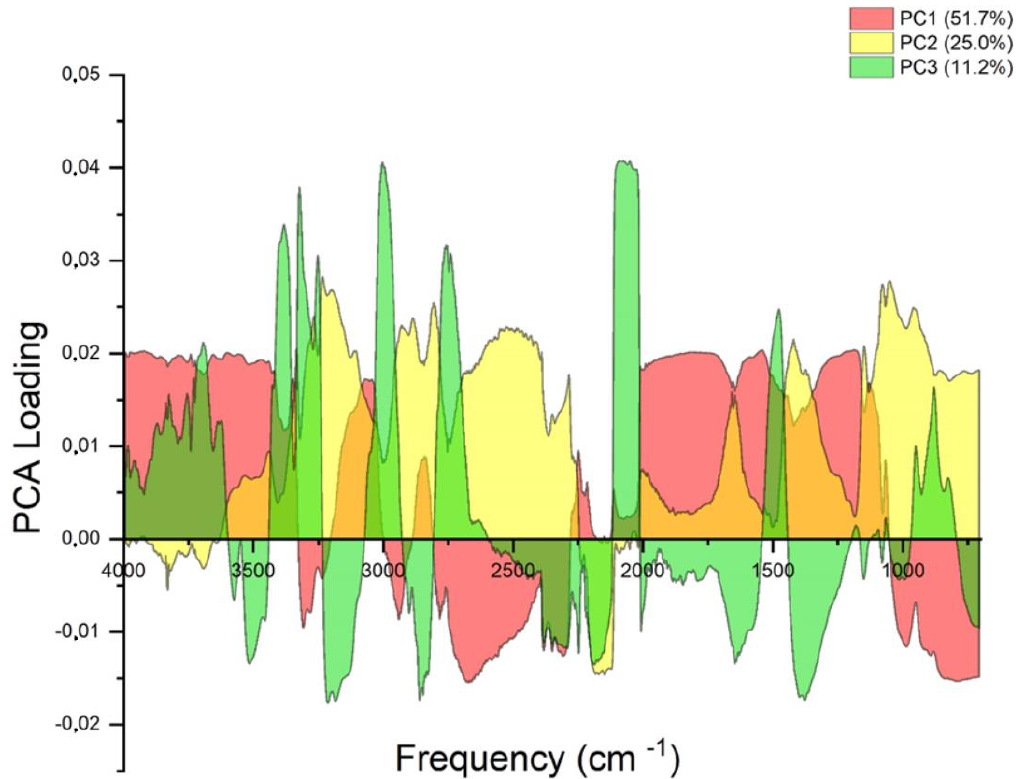
Figure 9. The loading factors of the principal component analysis (PCA).